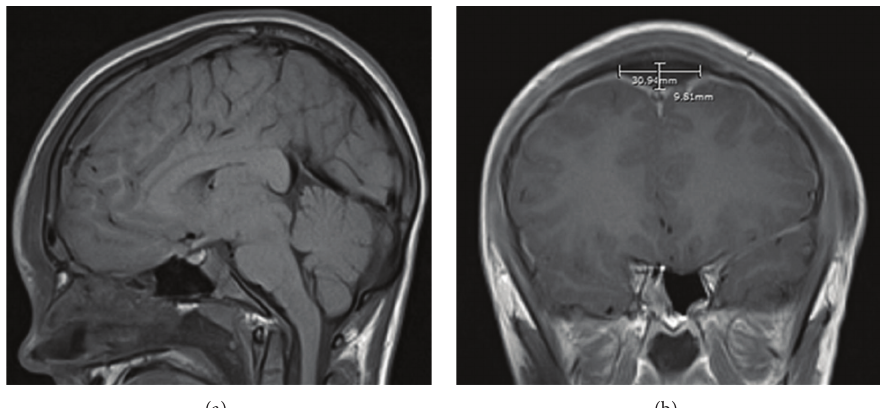
Figure 1: (a) MRI of the brain showing sagittal T1-weighted image after administration of contrast. The fluid collection reported to have a thin enhancing wall ran along the dorsal aspect of the superior sagittal sinus. (b) MRI of the brain showing coronal T1-weighted image after administration of contrast. Diffuse smooth dural enhancement is noted,